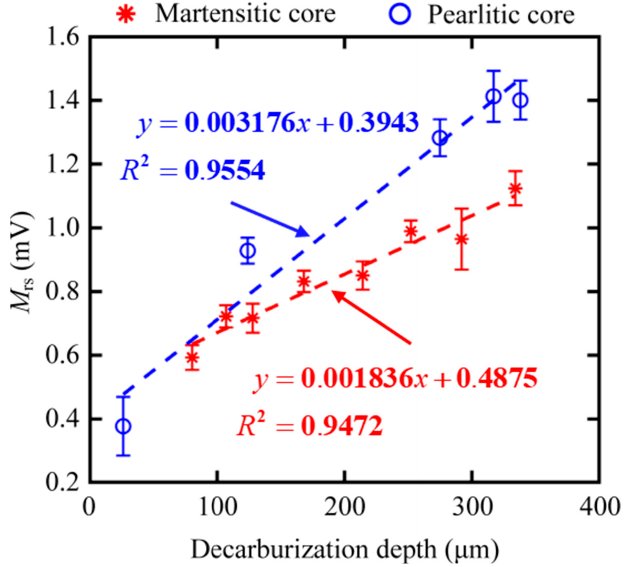
Figure 12. Dependencies of feature M rs on the surface decarburization depths for all samples with martensitic and pearlitic cores.